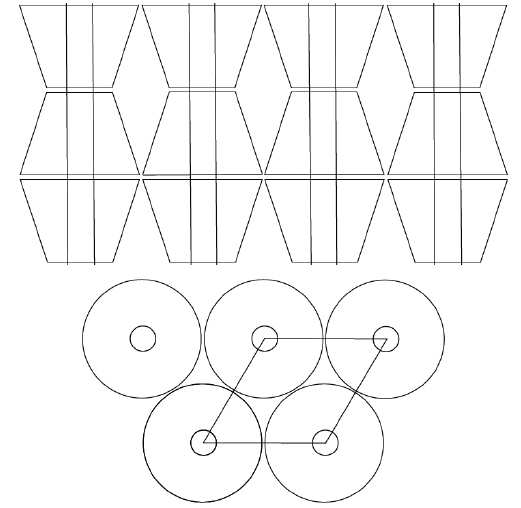
Figure 4. Channel structure of a columnar CD-IC, with 0.6 ( α -CD), 0.8 ( γ -CD) N-6 chains/nm 2 of CD-IC crystal surface. Threaded chains are ~1.5–1.8 nm apart, so the protruding N-6 chains form dense polymer brushes [18] (For comparison, in the α -form bulk crystal there are 1.4 N-6 chains/nm 2 )